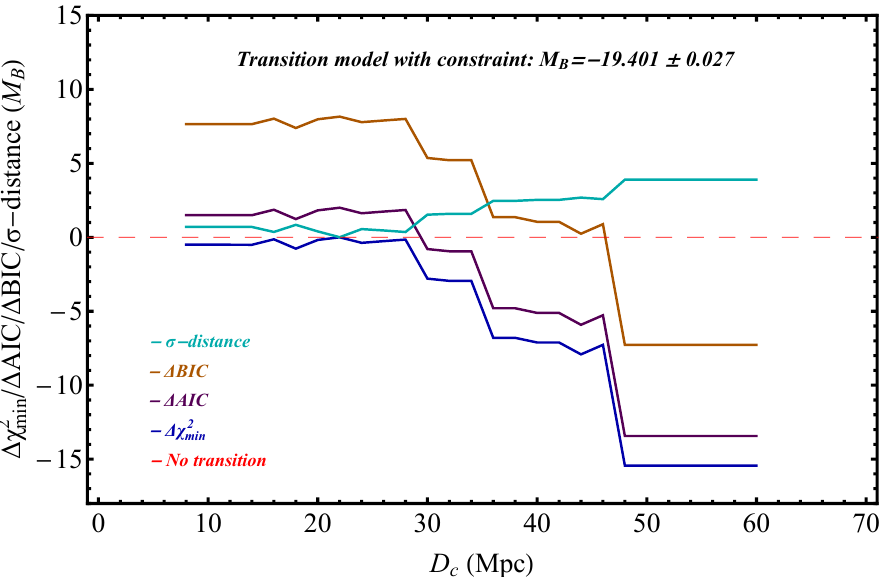
Figure 15. Model selection criteria of the M B transition model with respect to the baseline SH0ES model in the presence of the inverse distance ladder constraint (35). The σ -distance between the low-distance best-fit M < and the high-distance M > is also plotted in terms of D c . Clearly, the M B B B transition model is strongly preferred with respect to the SH0ES baseline (no transition) model, especially for transition distances D c (cid:39) 50